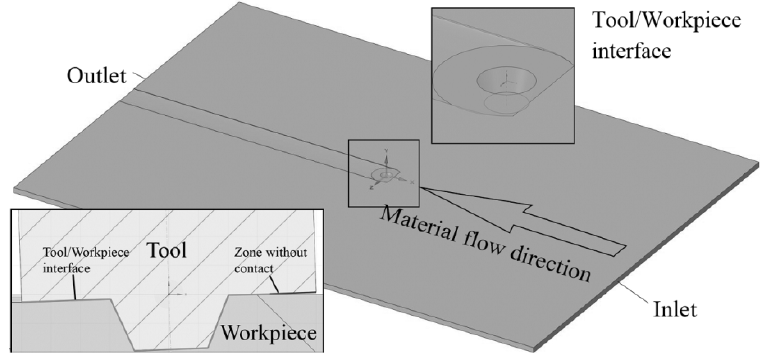
Figure 4. Scheme of the domain, tool position, and tool geometry.